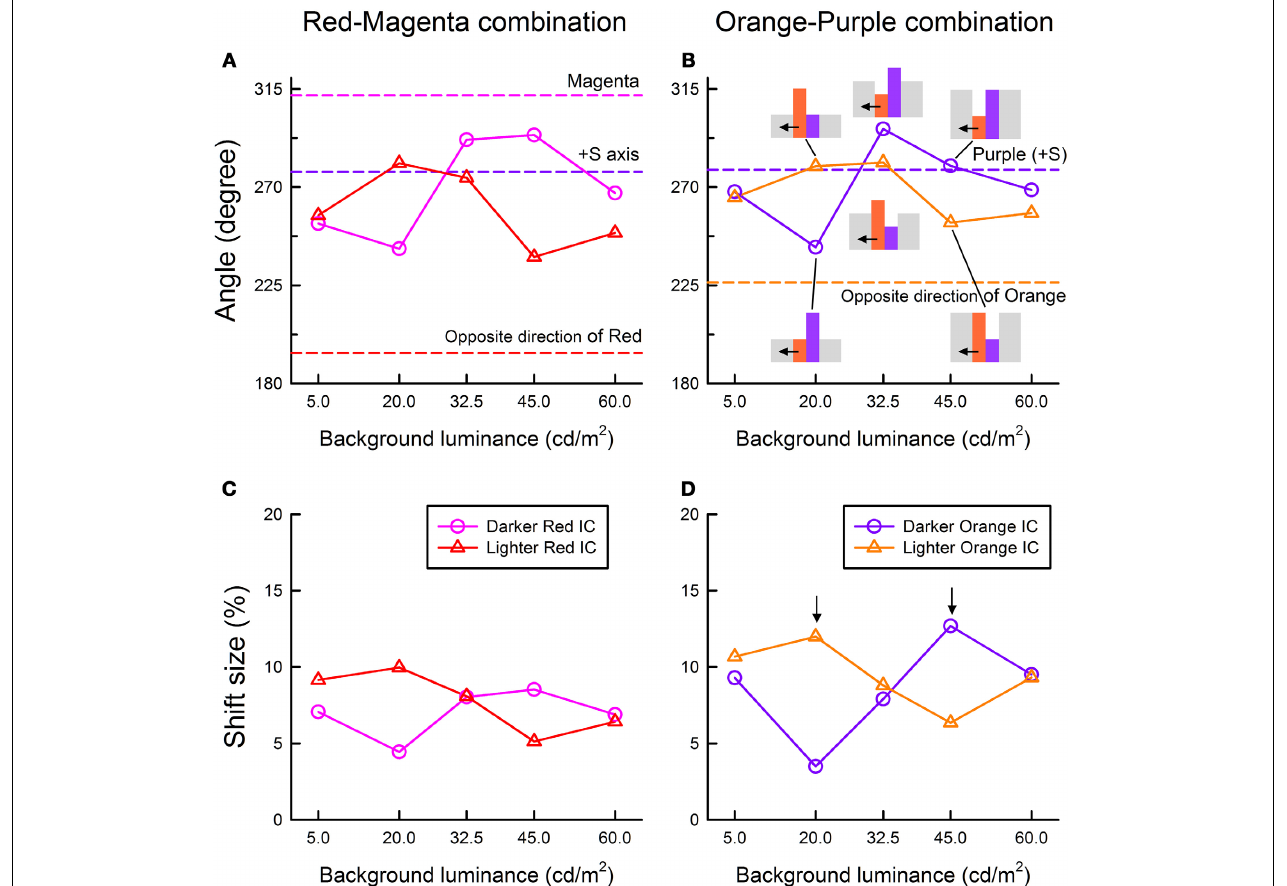
FIGURE 6 | Color direction and shift size of the cancelation settings as a function of the background luminance. (A,C) The results for the red IC and magentaOCcombination,and (B,D) theresultsfortheorangeICandpurpleOC combination. Upper panels show the results of color direction analysis, whereas lower panels show the results of shift size analysis. Circle symbols